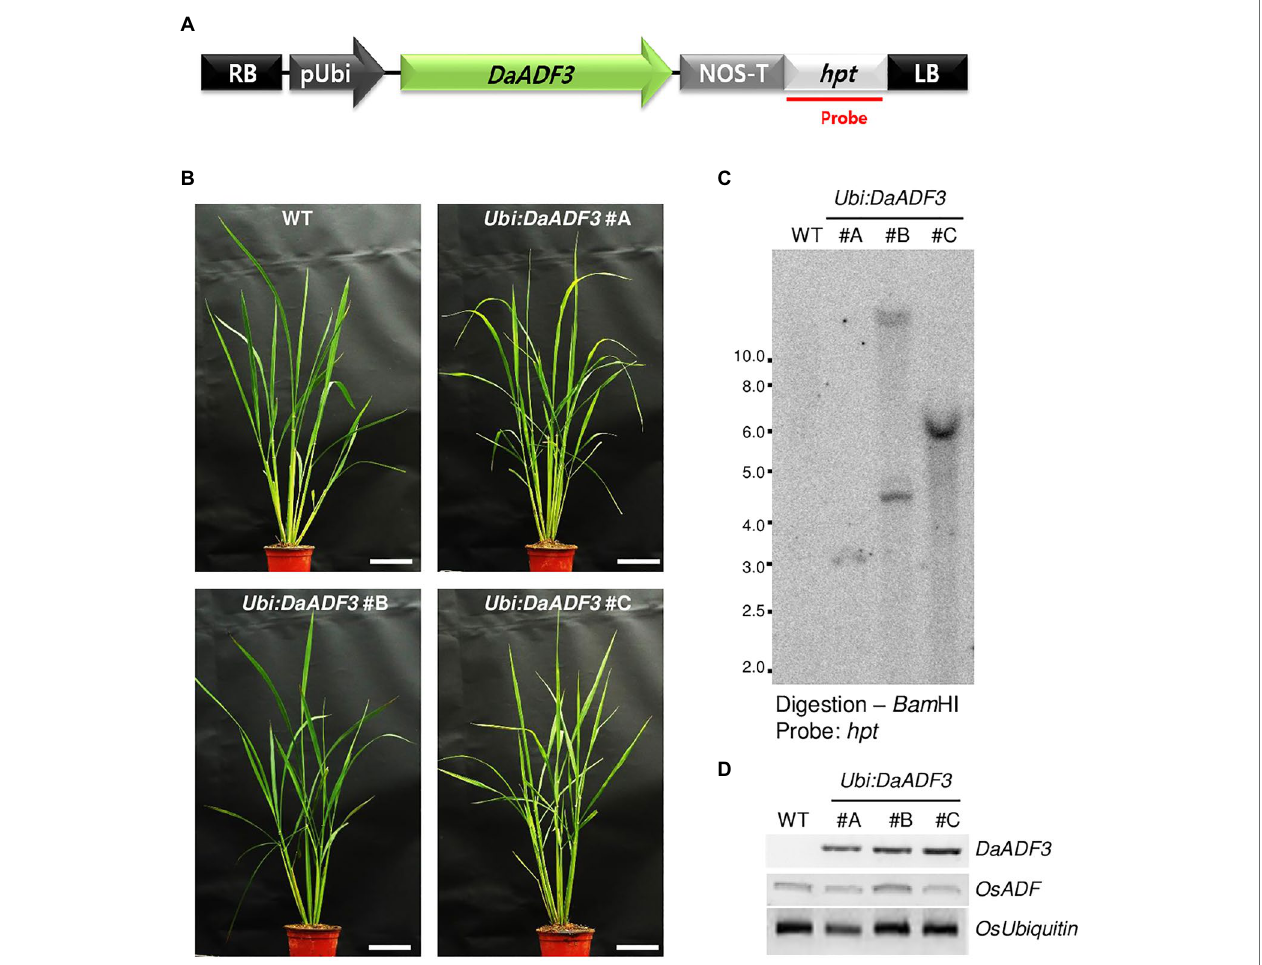
FIGURE 5 | Characterization of DaADF3 -overexpressing transgenic rice plants. (A) Schematic representation of a DaADF3 -overexpressing binary vector construct. Hpt , hygromycin phosphotransferase; LB, left border; pUbi, maize ubiquitin promoter; RB, right border; T-NOS, NOS terminator. (B) Morphology of 2-month-old wild-type (WT) and T3 Ubi:DaADF3 (independent lines #A, #B, and #C) transgenic rice plants grown under a long-day (16-h/8-h light/dark) photoperiod. Bars = 10 cm. (C) Genomic Southern blot analysis. Total leaf genomic DNA was extracted from WT and T3 Ubi:DaADF3 (lines #A, #B, and #C) rice plants. DNA was digested with Bam HI and hybridized to a 32 P-labeled hygromycin B phosphotransferase ( hpt ) probe. (D) RT-PCR analysis of the WT and T4 Ubi:DaADF3 (lines #A, #B, and #C) rice plants to examine DaADF3 overexpression. OsUbiquitin was used as a loading